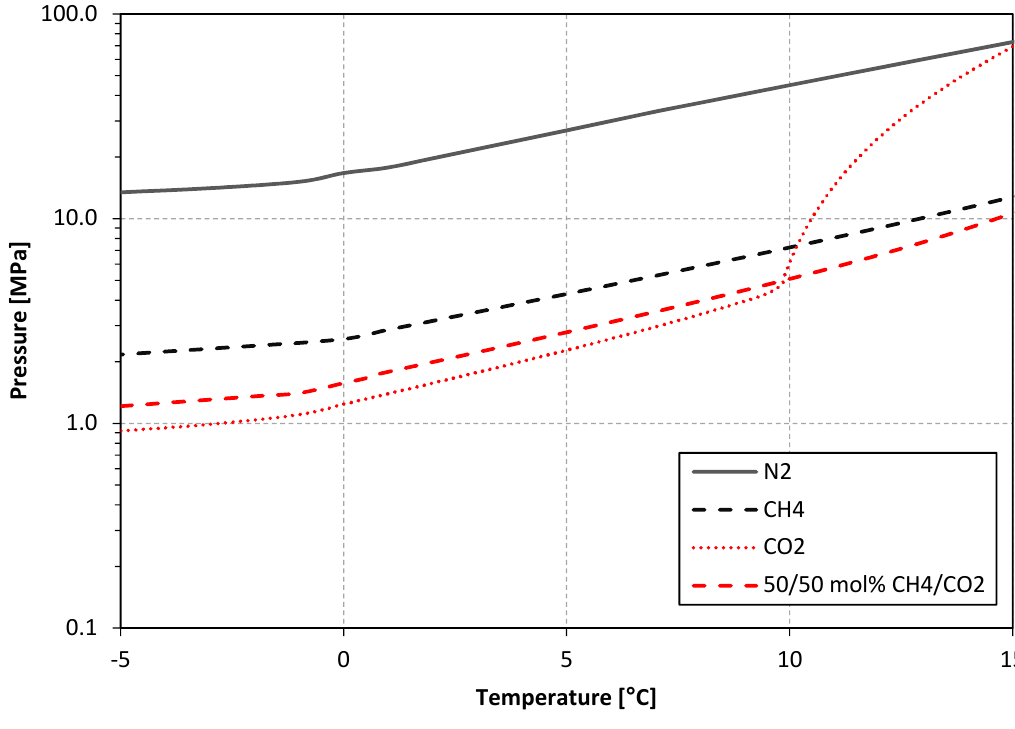
Figure 1. Comparison of stability for different guest molecule combinations. Pure CO 2 -hydrate is thermodynamically more stable relative to pure CH 4 -hydrate at certain temperature regimes, which is also observed for a binary gas composition of CH 4 and CO 2 . The plotted equilibrium three phase line is based on gas composition, and does not necessarily reflect the hydrate composition. N 2 does not stabilize hydrate cavities at the experimental conditions, but is included for comparison. Data generated using CSMGem